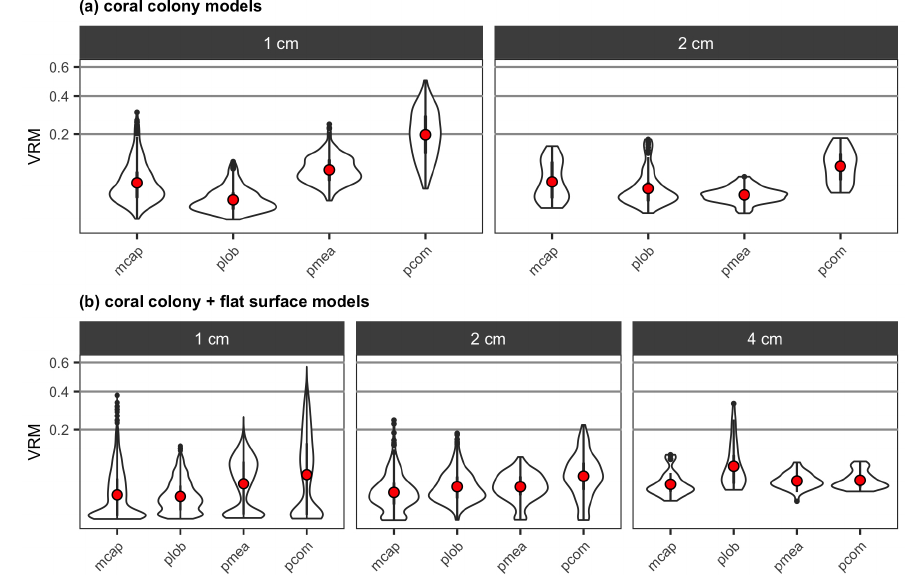
Figure 12. Violin plots for ( a ) VRM extracted at two different resolutions, 1 cm and 2 cm, from the DEMs of the four reconstructed coral colonies with different morphologies, and ( b ) VRM extracted at three different resolutions, 1 cm, 2 cm and 4 cm, from the DEMs of the four reconstructed colonies with different morphologies with a substratum: mcap = encrusting M. capitata , plob = mounding P. lobata , pmea = branching P. meandrina and pcom = branching P. compressa . The mean value of VRM for each colony is shown as red points. The coral colonies were too small to obtain VRM at 4-cm